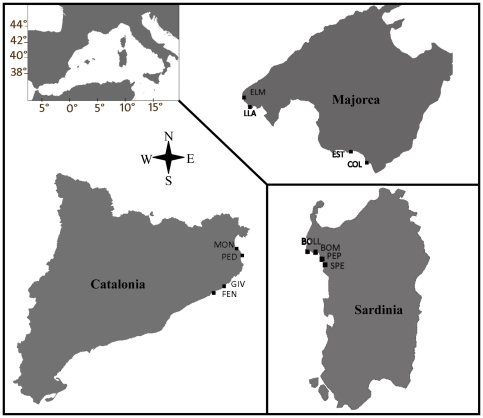
Map of the Western Mediterranean showing the three study regions and corresponding sites.In Catalonia: Montgó (Mon: 42°6.2′N; 3°10.1′E), Isla Pedrosa (Ped: 42°4.2′N; 3°12.1′E), Giverola (Giv: 41°44.1′N; 2°57.1′E), and Fenals (Fen: 41°41.3′N; 2°49.6′E); in Sardinia: Torre Bollo (Boll: 40°34.1′N; 8°9.5′E), Bombarde (Bom: 40°34.5′N; 8°15.4′E), Pepino (Pep: 40°32.2′N; 8°19.3′E), and Sperança (Spe: 40°29.4′N; 8°21.6′E); and in Majorca: Còlonia (Col: 39°18.5′N; 2°59.2′E), Estanyol (Est: 39°21.2′N; 2°54.6′E), St. Elm (Tel: 39°34.5′N; 2°20.5′E), and Cala Llamp (Lla: 39°31.5′N; 2°23.2′E).